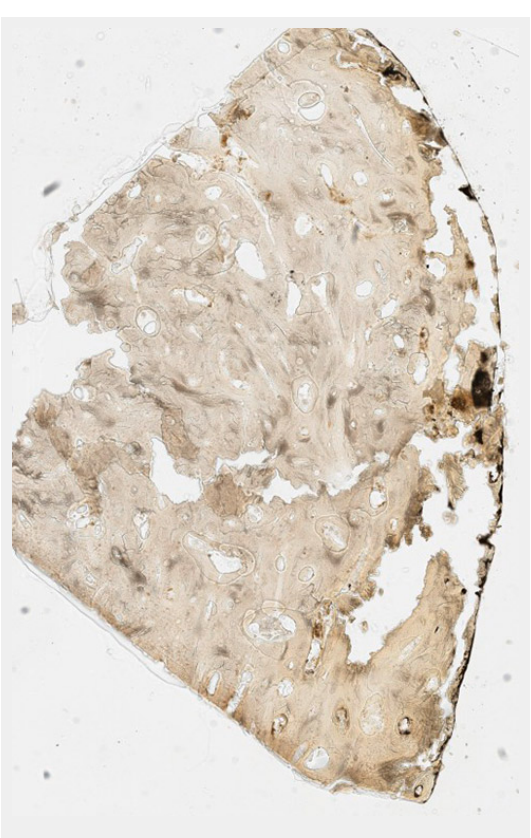
Paraffin embedding, haematoxylin and eosin, 40x. Sample taken out of the